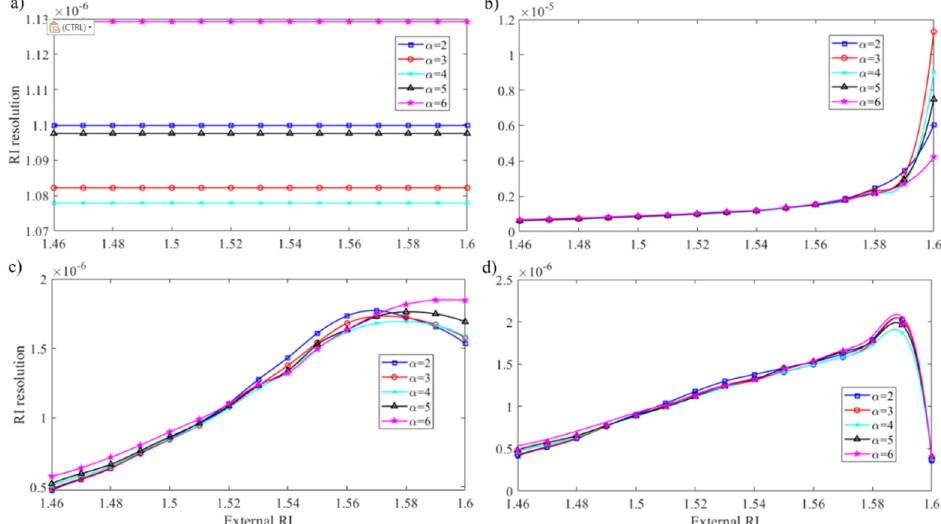
Figure 15. RI resolution for ( a ) linear, ( b ) quadratic, ( c ) cubic and ( d ) quartic fitting functions with different α along the 1.46–1.60 range.